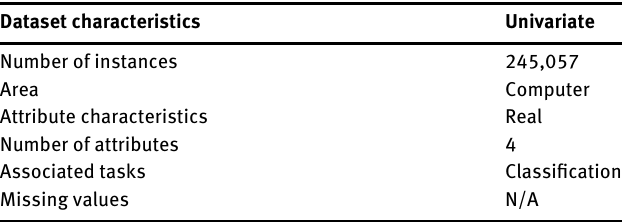
Table 2: Description of Skin Segmentation